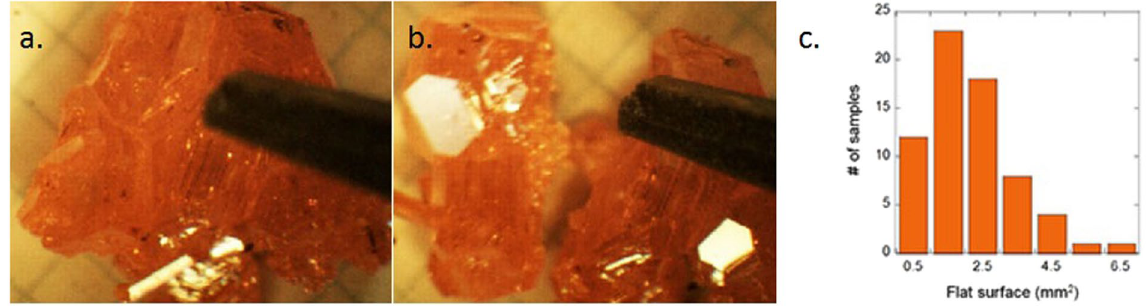
Figure 1. ( a ) Optical image of a cluster of CH 3 NH 3 PbBr 3 single crystals mechanically stressed by the tip of a tweezers; ( b ) the broken-up cluster liberates a shiny, mirror-like surface previously embedded in the twinned crystals (the millimetre paper below the crystals show the scale); ( c ) Histogram of the cleaved, clean surface size of the